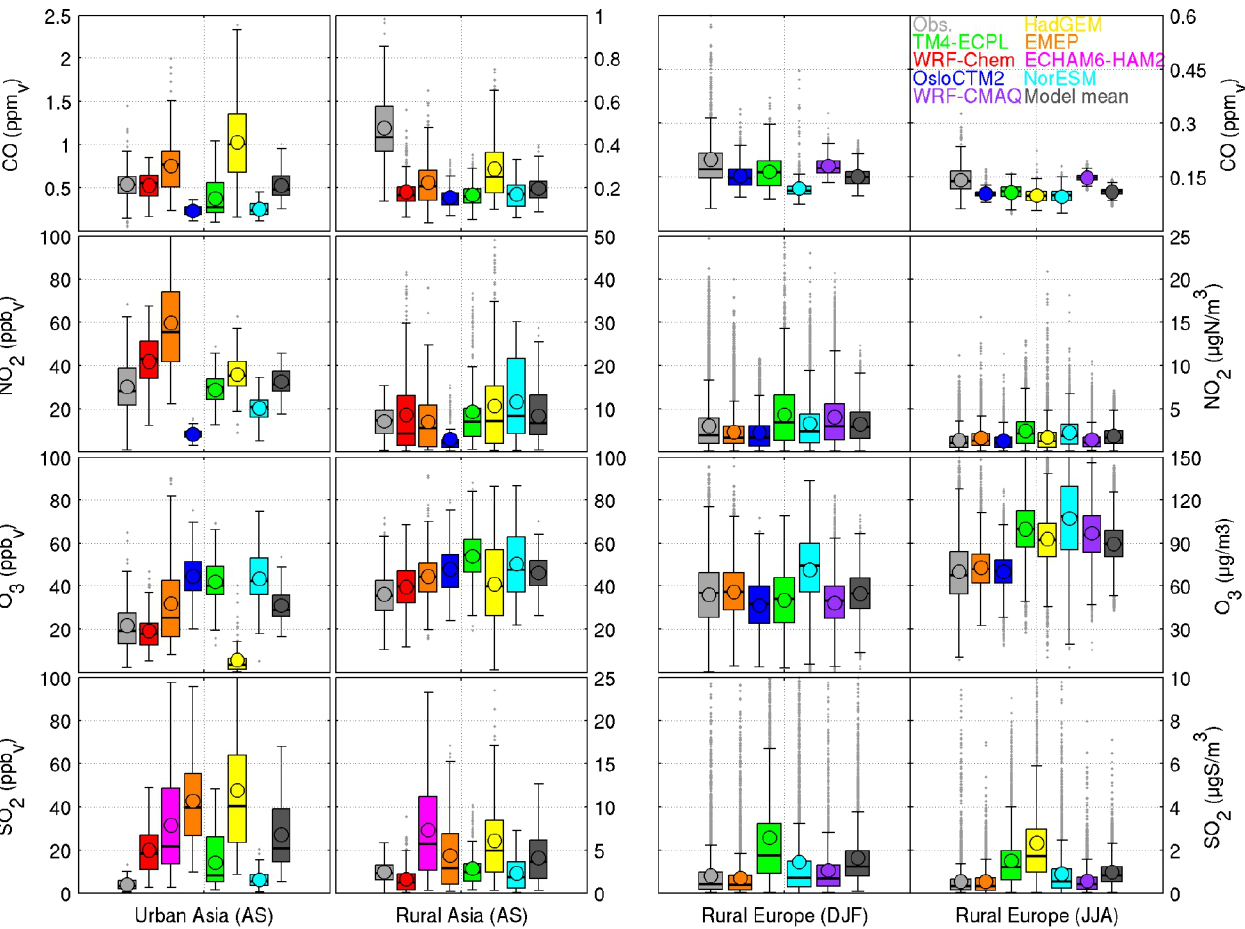
Figure 3. Box and whiskers plots showing the frequency distribution of measured and modelled CO, NO 2 , O 3 and SO 2 mixing ratios or concentrations representative for background stations in urban and rural areas in East Asia during August and September 2008 (two left panel columns) and for rural background stations in Europe for winter (December–February, DJF) and summer (June–August, JJA) 2008 (two right panel columns). Circles and central lines show the means and the medians, respectively; box edges represent the 25th and the 75th percentiles. For East Asia, results are averaged over several sites: Beijing, Inchon and Seoul for the urban areas, and Gosan, Kunsan, Kangwha, Mokpo and Taean for rural areas. Results for individual sites can be found in Quennehen et al. (2015). For Europe, daily mean observed values are averaged over all stations of the European Monitoring and Evaluation Programme (EMEP) network with available data. Model data are treated like the observations and only the days with available observations are taken into